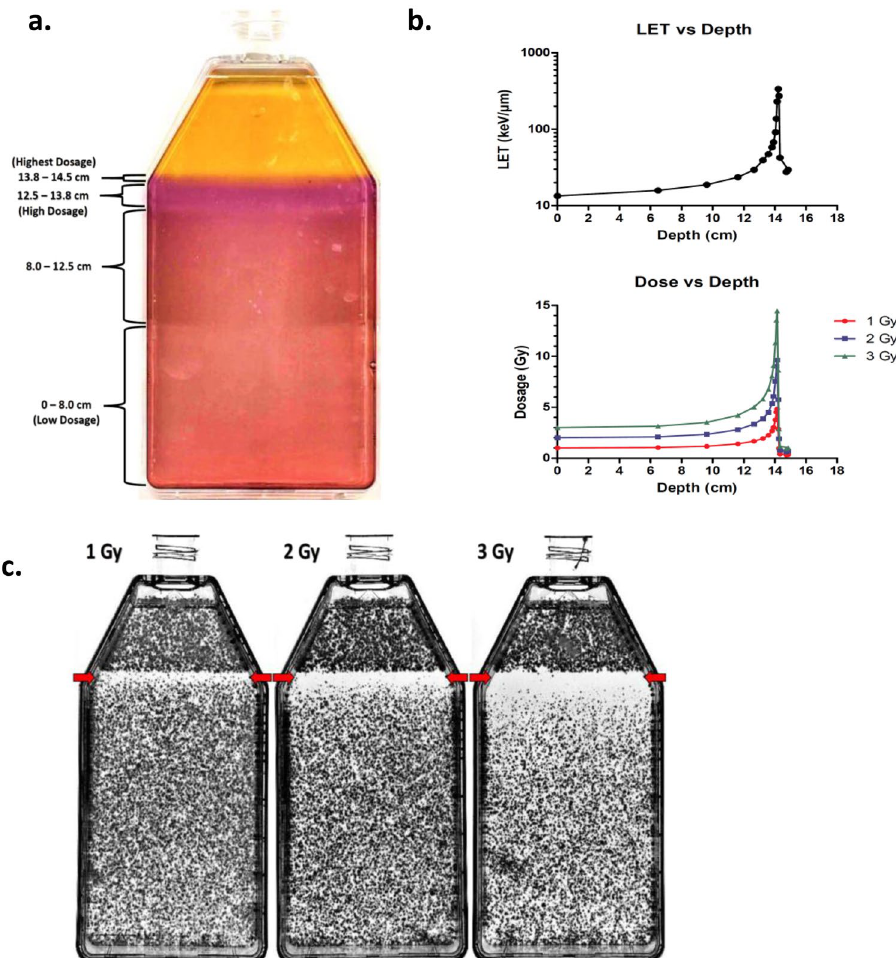
Figure 1. Dose distribution and biological Bragg peak depth. ( a ) Fricke gel dosimetry visual representation of carbon-ion beam depth vs dose distribution in our T-175 cell culture flask. Fricke gel indicated the highest dosage, therefore the Bragg peak, was located between the depths of 13.8 and 14.5 cm. ( b ) Graphs depicting LET vs depth (top) and dosage vs depth (bottom) from the calculated values of LET and dosage at specific depths provided by faculty at NIRS. ( c ) Images of cell survival assay T-175 cell culture flasks following carbon-ion beam irradiation of 1, 2 or 3 Gy dosages. Flasks portrayed the least number of colonies under all initial radiation conditions at the depth of 14.5 cm, representative of our biological Bragg peak depth. Red arrow: indicates biological Bragg